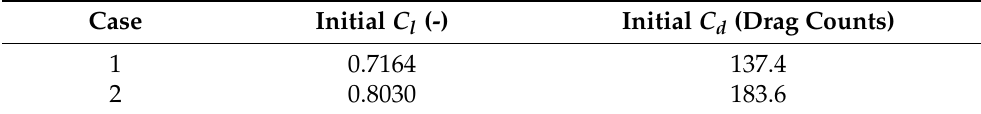
Table 3. Case studies for the RAE2822 airfoil analyzed and optimized in the